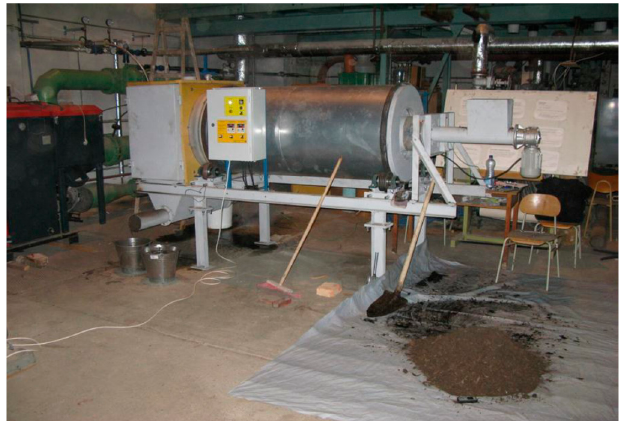
Figure 5. Steam heated rotary dryer.